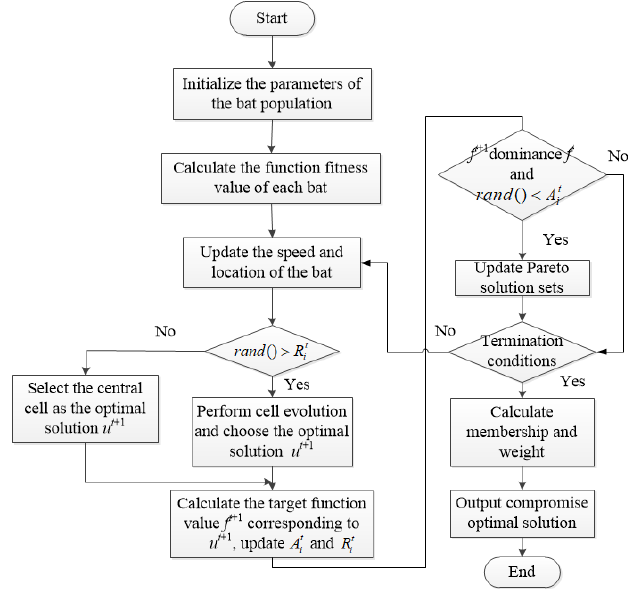
Figure 1. The flow chart of FMD-CBA.